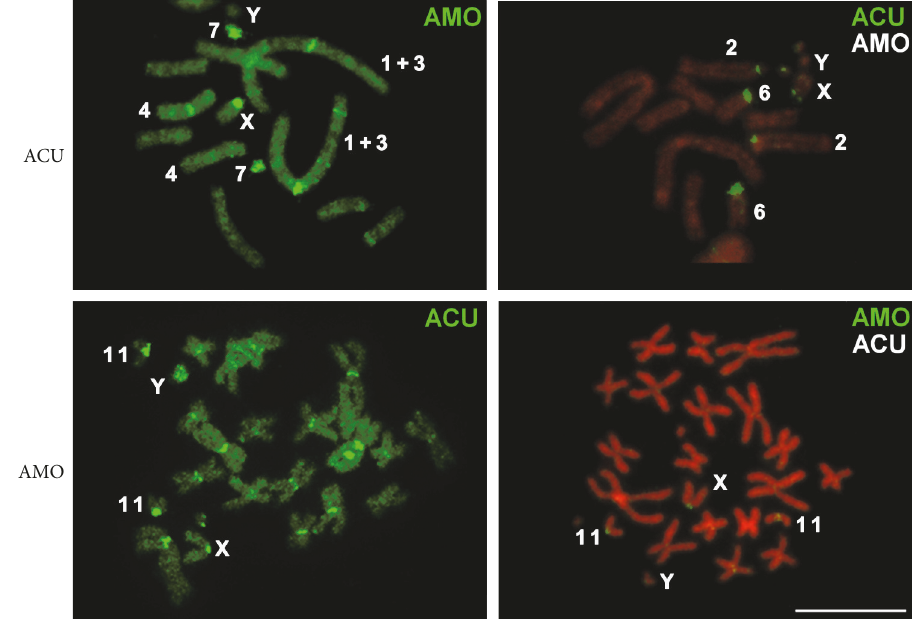
Figure 3: Interspeci fi c GISH among Akodon cursor (ACU) and A. montensis (AMO). The initials on the left correspond to the species cells. The labeled DNA used is identi fi ed in green and the suppressor DNA is represented in white. All the cells were counterstained with propidium iodide. Bar=10 μ